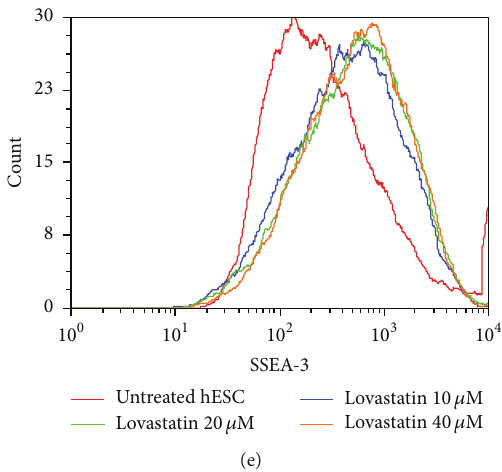
Figure 1: Lovastatin treatment differently affects the expression of pluripotency markers in hES cells. (a) Flow cytometric analysis of the expression of the pluripotency markers NANOG, OCT4, and SOX2 in hES cells treated with lovastatin (20 𝜇 M lovastatin for 48 h) and those untreated. Fixed and permeabilised cells were stained with anti-SSEA-3 (Alexa Fluor 488 conjugate), anti-NANOG (PE), anti-OCT4 (Alexa Fluor647),andanti-SOX2(PerCpCy5.5conjugate)antibodiesandwithDAPI.Foranalysiscellulardebrisanddoubletswereexcluded.(b)The morphological changes in colony structure of lovastatin treated hES cells. (c) The number of cells expressing pluripotency markers. Results are shown as mean ± SD ( 𝑛 = 5 ). (d) The number of cells in one well after 48h of treatment with lovastatin. (e) Changes in SSEA-3 expression in untreated and lovastatin treated (10–40 𝜇 M for 24 h) hES